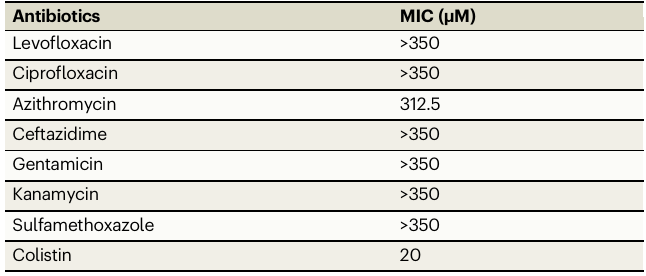
MIC-Meaninhibitoryconcentrationexpressedinmicromolarconcentration.Antibioticresistance pro fi le of E. coli PI-7 showingthat the strain is resistant to antibiotics belongingto the fl uor- oquinolone class (MICforlevo fl oxacin and cipro fl oxacin: >350µM), macrolide (MIC forAzi- thromycin: 312.5µM), cephalosporin (MIC forceftazidime:>350 μ M),aminoglycoside (MICfor gentamicin andkanamycin:>350 μ M),sulfonamide (MICforsulfamethoxazole: >350 μ M)